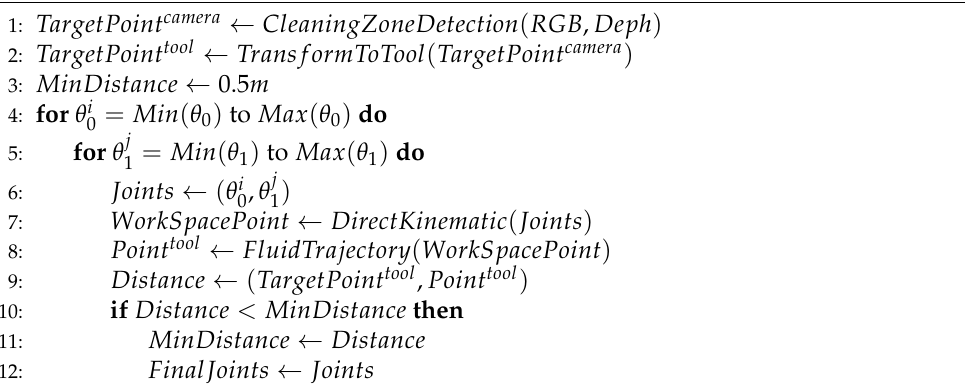
Figure 6. Diagram of the targeting system for choosing the optimal joint variables to hit the target point of the insulator. Algorithm 1 Algorithm to obtain the optimal joints to hit the